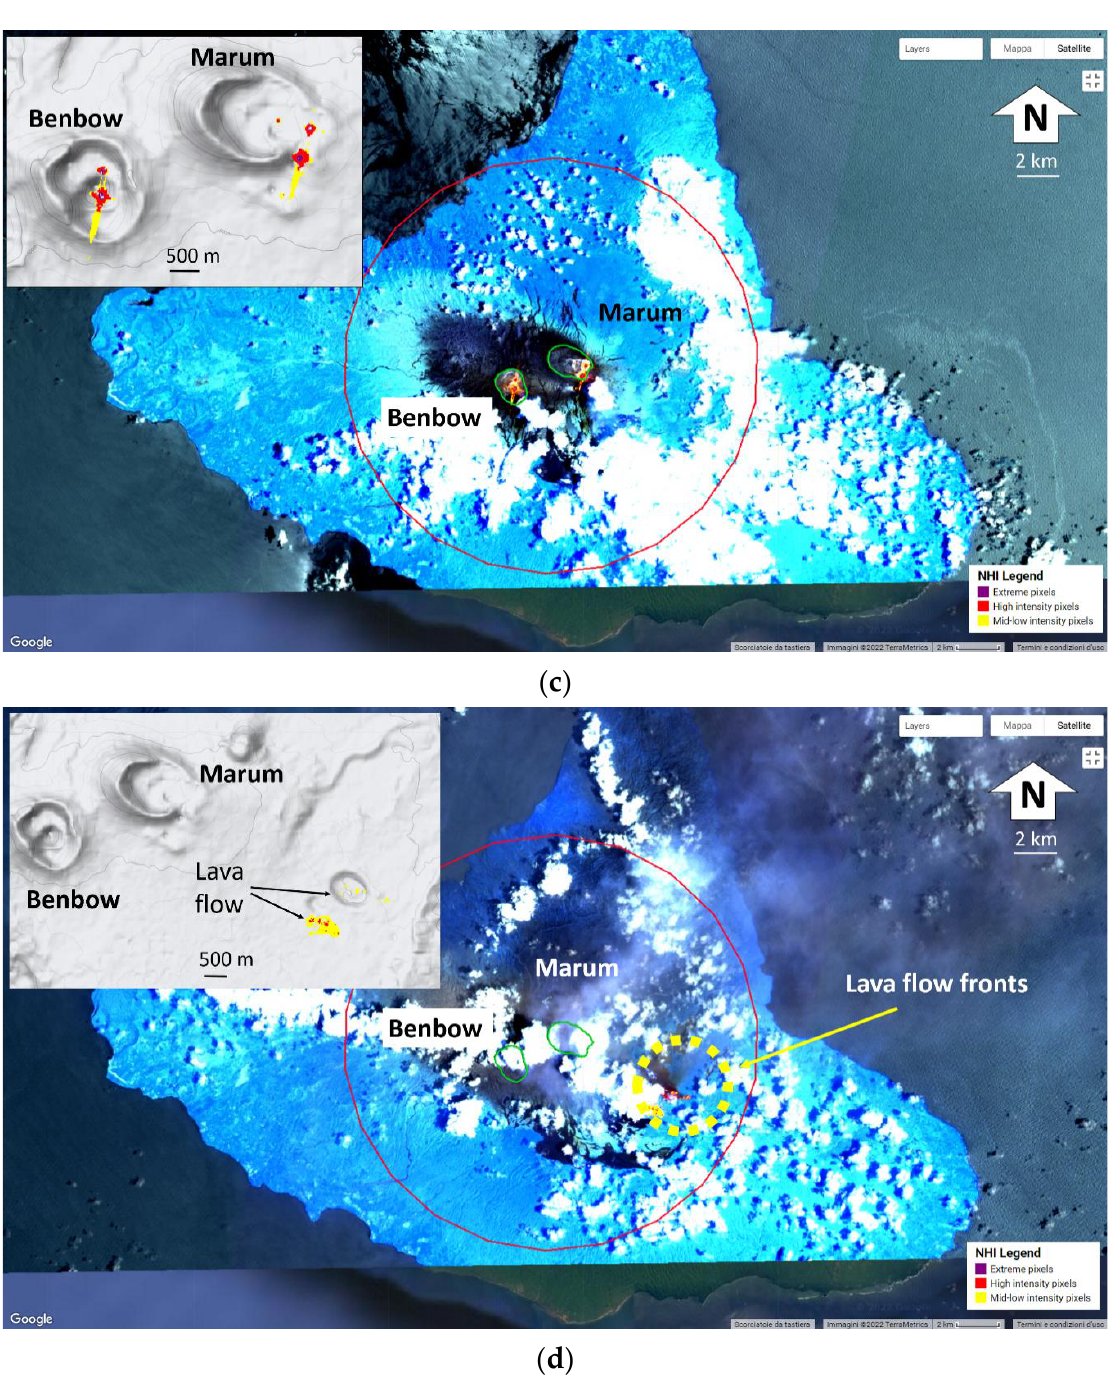
Figure 3. Thermal anomaly maps generated from: ( a ) L8-OLI scene of 20 August 2017; ( b ) S2-MSI scene of 8 June 2018 at 23:09 UTC; ( c ) S2-MSI scene of 25 November 2018 at 23:09 UTC; ( d ) S2-MSI scene of 15 December 2018 at 23:09 UTC. In the inset, the RGB (Red = SWIR2; Green = SWIR1; Blue = NIR) imagery. On the top panel, in purple, is the center of the circular area that is depicted in red, and associated with a distance buffer (DB) of 10 km, the Benbow and Marum craters ’ rims are in green.